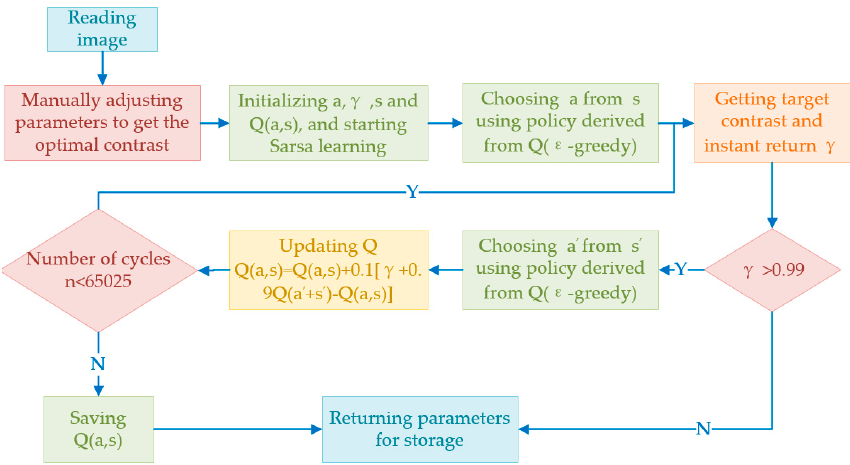
Figure 4. The Sarsa learning flow chart.